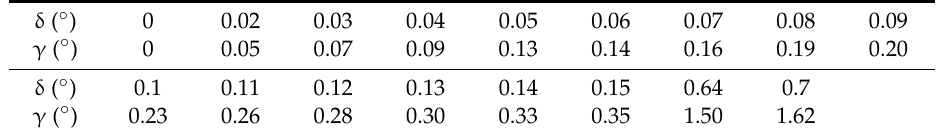
Table 2. Angles between incident ray and retroreflected ray γ with respect to δ , which is the dihedral angle of retroreflector corner cube surface with 90 ° as the reference.